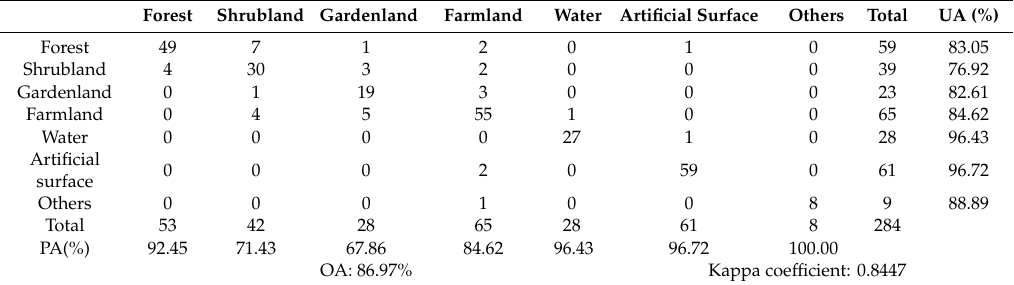
Table 3. Accuracy validation of land-cover type classification results based on fusion image. Forest Shrubland